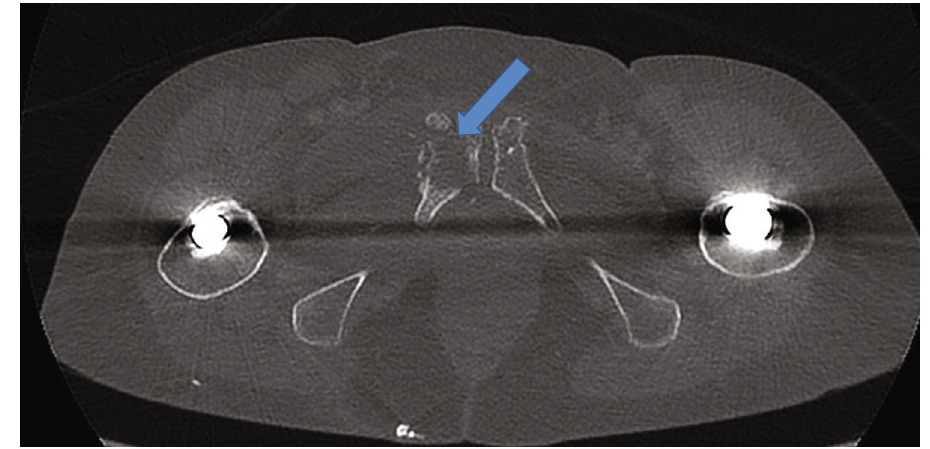
Figure 3: CT scan showing destruction of pubic bone and fl uid collection suggesting acute